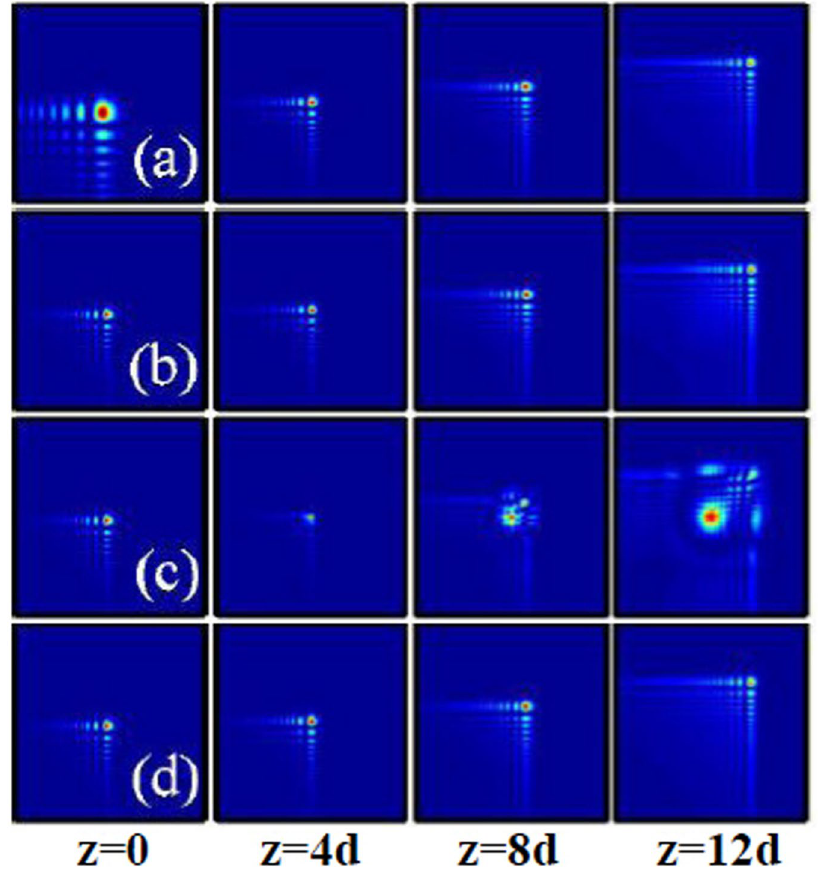
Figure 2. The intensity distributions of two-dimensional fundamental Airy beam at different propagation distances in ( a ) free space, ( b , c ) local self-focusing nonlinear media ( σ = 0), and ( d ) nonlocal nonlinear media, respectively. The initial parameters are m = 0, x 0 = y 0 = 0, A = 5 ( a , b ), and A = 10 ( c , d ). The degree of nonlocality of Fig. 2(d) is σ =